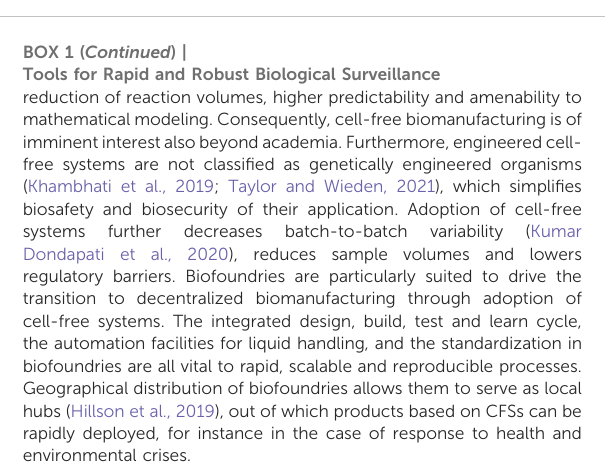
Frontiers in Bioengineering and